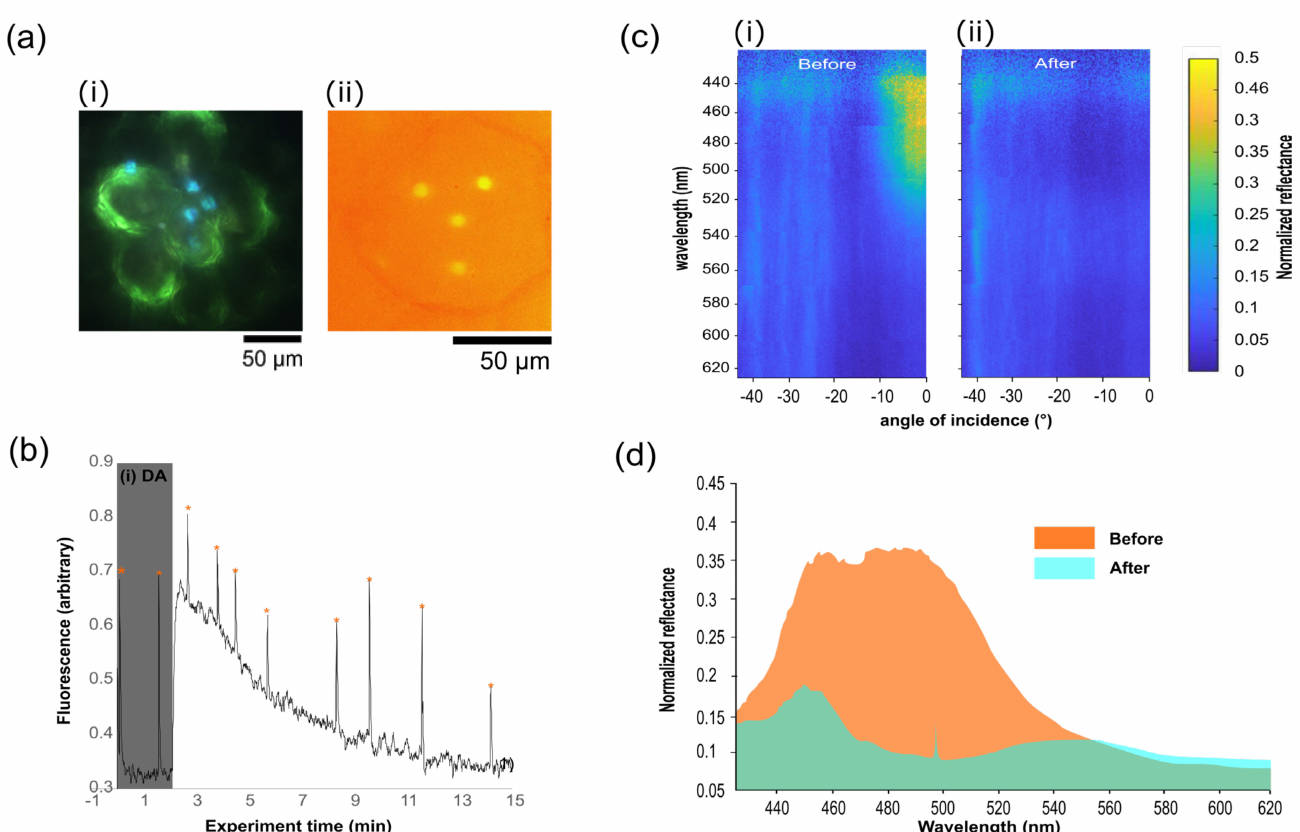
Figure 3. Photonic Begonia sp. in combined PAM-microscatterometry setup. ( a ) (i) shows sample selection in the microscope at 100 × magnification. (ii) depicts fluorescence measurements of iridoplasts using the PAM camera. ( b ) PAM photosynthesis induction curve following (i) dark adaption (DA)